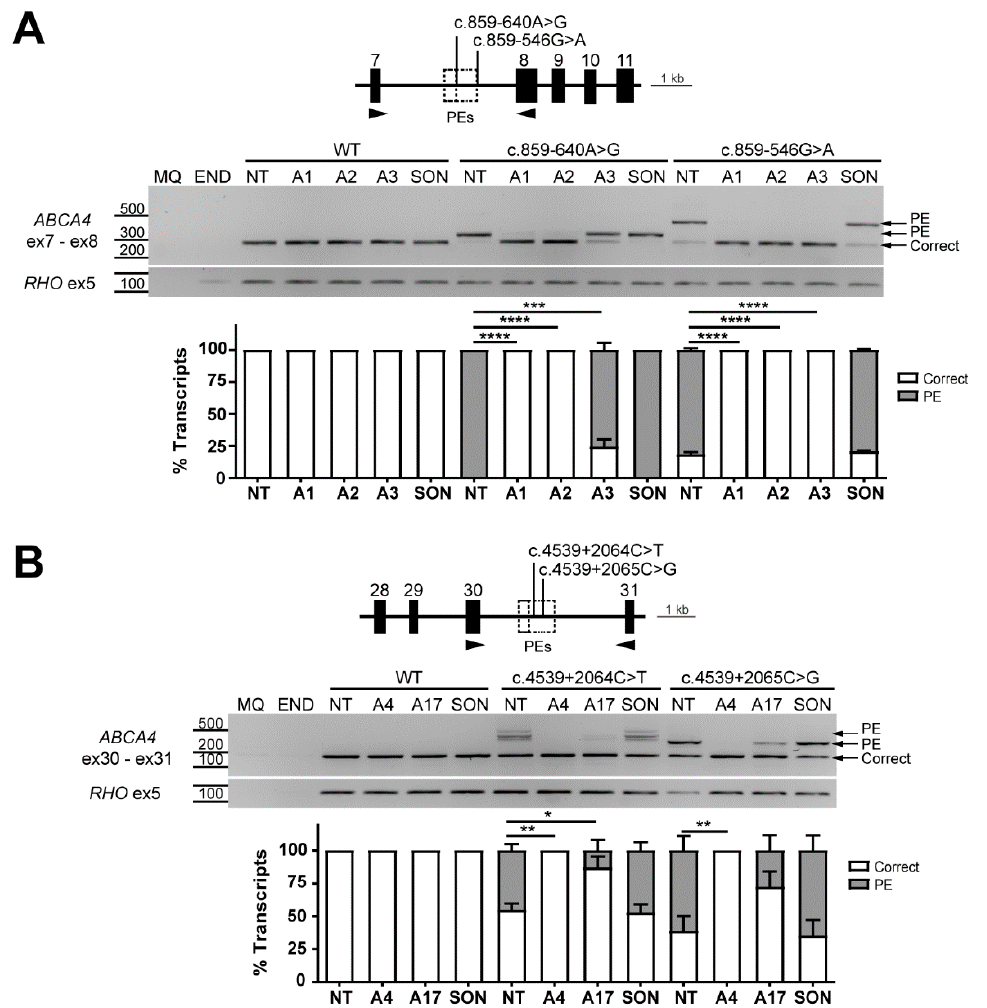
Figure 4. Antisense oligonucleotide (AON)-mediated rescue for deep-intronic splice variants causing similar pseudoexon (PE) inclusions in the same region. Analysis of splicing correction by reverse transcription polymerase chain reaction (RT-PCR) upon AON (A#) delivery. Wild-type (WT) midigenes and the corresponding mutant midigenes containing deep-intronic variants c.859-640A>G/c.859-546G>A ( A ) and c.4539+2064C>T/c.4539+2065C>G ( B ) were transfected in HEK293T. Non-transfected HEK293T were used as endogenous expression control (END). The different AONs and a SON were then delivered, except for the non-treated lanes (NT). Genomic region of the different midigenes is depicted on top of each representative RT-PCR image, whereas the graphs below represent the semi-quantification of the resulting RT-PCR products, showing the percentage of correct and PE-including transcripts. AON1 and 2 could rescue 100% of the correct transcript for both c.859-546G>A and c.859-640A>G variants, while AON4 completely redirected splicing in the case of c.4539+2064C>T and c.4539+2065C>G. MQ shows the negative control of the PCR reaction and amplification of exon 5 of rhodopsin ( RHO ) gene was used as a transfection control. Data (n = 2) are presented as mean ± SD. Statistical significance is indicated as * p < 0.05, ** p < 0.01, *** p < 0.001 and **** p < 0.0001 using one-way ANOVA.